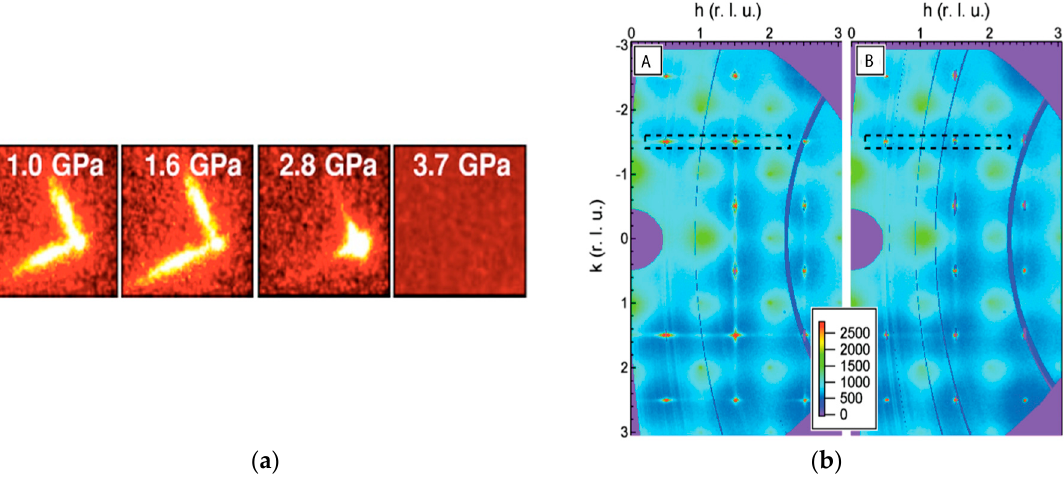
Figure 8. The diffuse scattering streaks in single-crystal diffraction pattern of Na 0.5 Bi 0.5 TiO 3 are proposed to come from nanoscale tetragonal inclusions within a rhombohedral matrix. ( a ) Weakening and eventual disappearance of diffuse streaks with increasing pressure. Reprinted from reference [45] DOI: 10.1103/PhysRevB.68.014113, with permission from the American Physical Society. ( b ) Similar effect observed for change in diffuse scattering patterns measured under zero field (A) and under electric field of 4.6 kV/mm (B). Reprinted from reference [78], with permission from AIP Publishing.